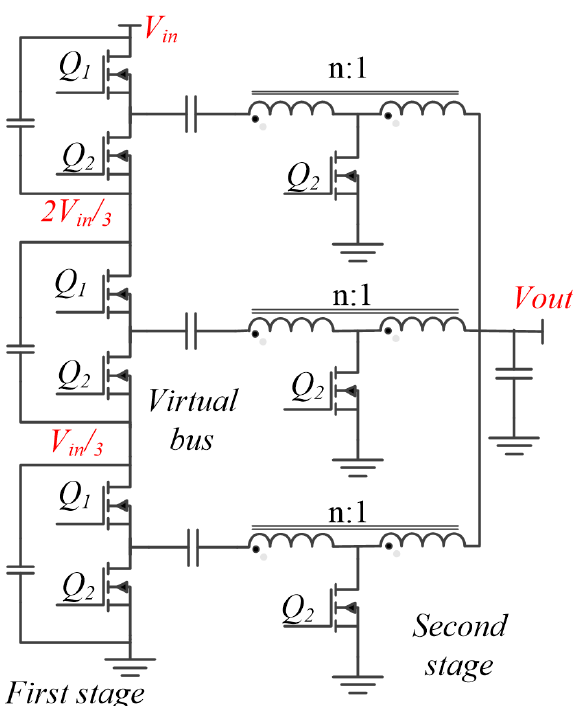
Figure 12. Dual-stage converter with a virtual